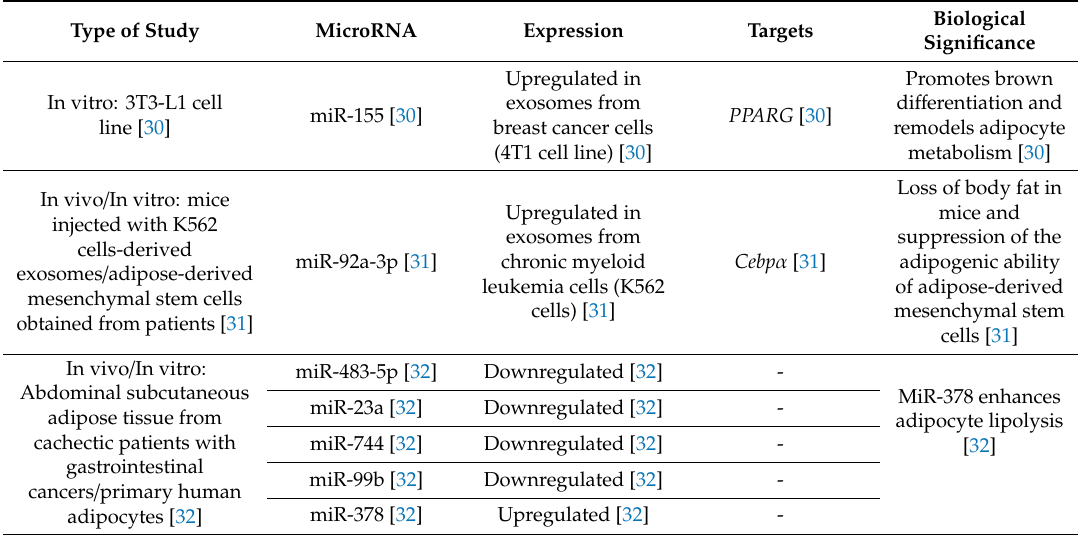
Table 2. MicroRNAs (miRs) involved in adipose tissue